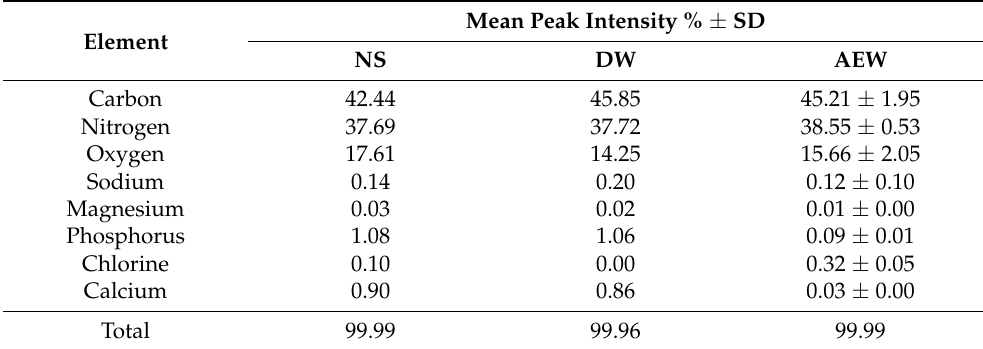
Figure 3. SEM photographs of fresh bone group, without any treatment ( a , b ), DW bone group ( c – e ), and AEW bone group ( f – h ). Fresh bone group : ( a ) smooth clear surface with few destroyed fibers ( ), ( b ) physiological cracks around 5 μ m in length (arrow). DW bone group : ( c ) linear smooth and rough surface structure, ( d ) rough scaly bone surface with micro damage or linear cracks (arrow), ( e ) densely arranged microstructure with destroyed fibers ( ) along with linear cracks (arrow). AEW bone group : ( f ) heterogeneous smooth and irregular surface structure with multiple cracks (arrow), ( g ) distinct linear cracks (arrow), ( h ) network of damaged fibers ( ). Table 1. Elemental analysis values of SEM-EDS spectra for skull parietal bone irradiated ultrasonically with different